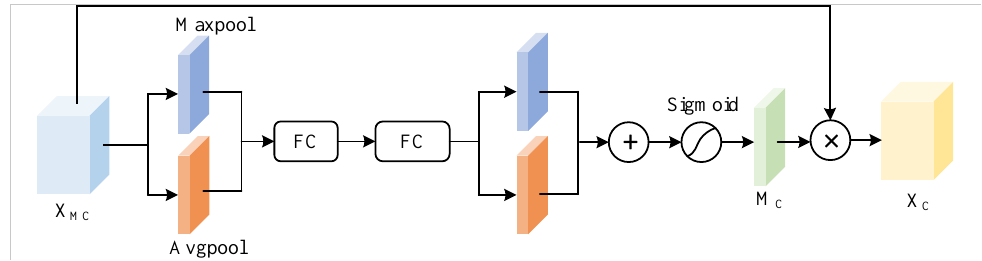
Figure 5. Diagram of channel attention